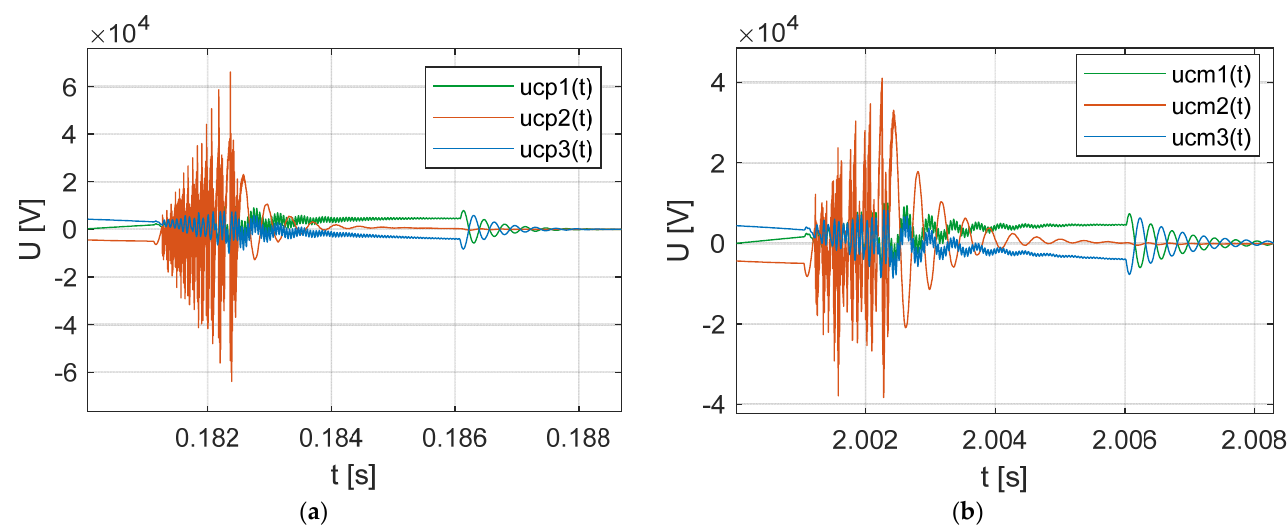
Figure 17. Load voltage ( a ) EMTP algorithm; ( b ) Clark transformation. Source: own calculations.